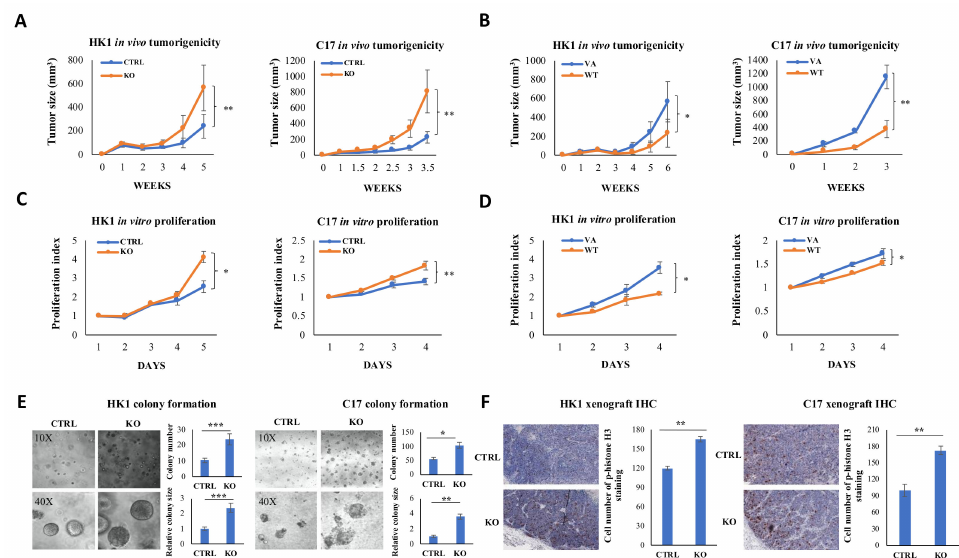
Figure 2. CYLD inhibits NPC tumorigenicity in vivo and cell proliferation in vitro . ( A ) Nude mice subcutaneous injection was performed to assess CYLD e ff ects on tumorigenicity in vivo . After CYLD knockout, both HK1 and C17 show significantly faster tumor growth compared to the control. n = 12. ( B ) With CYLD over-expression, both HK1 and C17 show significantly slower tumor growth than for the VA. n = 12. ( C ) CYLD knockout increases cell proliferation. ( D ) CYLD overexpression suppresses cell proliferation in HK1 and C17. ( E ) HK1 and C17 cells with CYLD knockout form more colonies with larger sizes in the 3D colony formation assay. Representative images are shown under 10 × and 40 × magnification. ( F ) Immunohistochemical (IHC) staining of HK1 and C17 xenografts shows more cells in mitosis in the CYLD knockout group. The quantitative data are shown in the bar graphs. Scale bar = 1000 µ m. The data are represented as mean ± standard deviation (SD); n = 3. CTRL: nontarget control; KO: CYLD -targeted knockout. *: p -Value < 0.05; **: p -Value < 0.01; ***: p -Value <